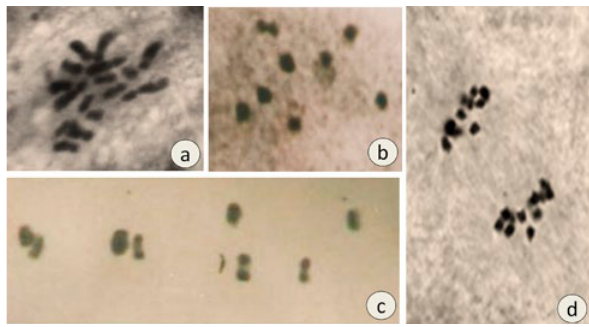
Fig. 2. Cytogenetic characterization of F 1 hybrid showing 2n=2x=16 chromosome configuration at mitotic metaphase (a), association of eight bivalents at diakinesis (b) and metaphase-I (c), and segrega- tion of chromosome at anaphase-I (d).